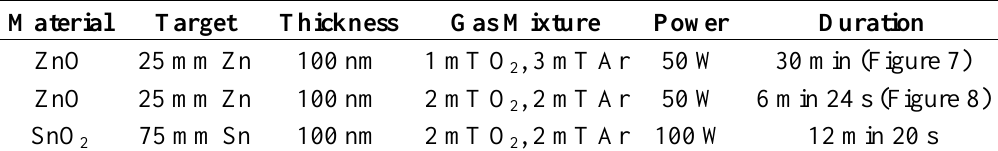
Table 1. Sputtering conditions for ZnO and SnO